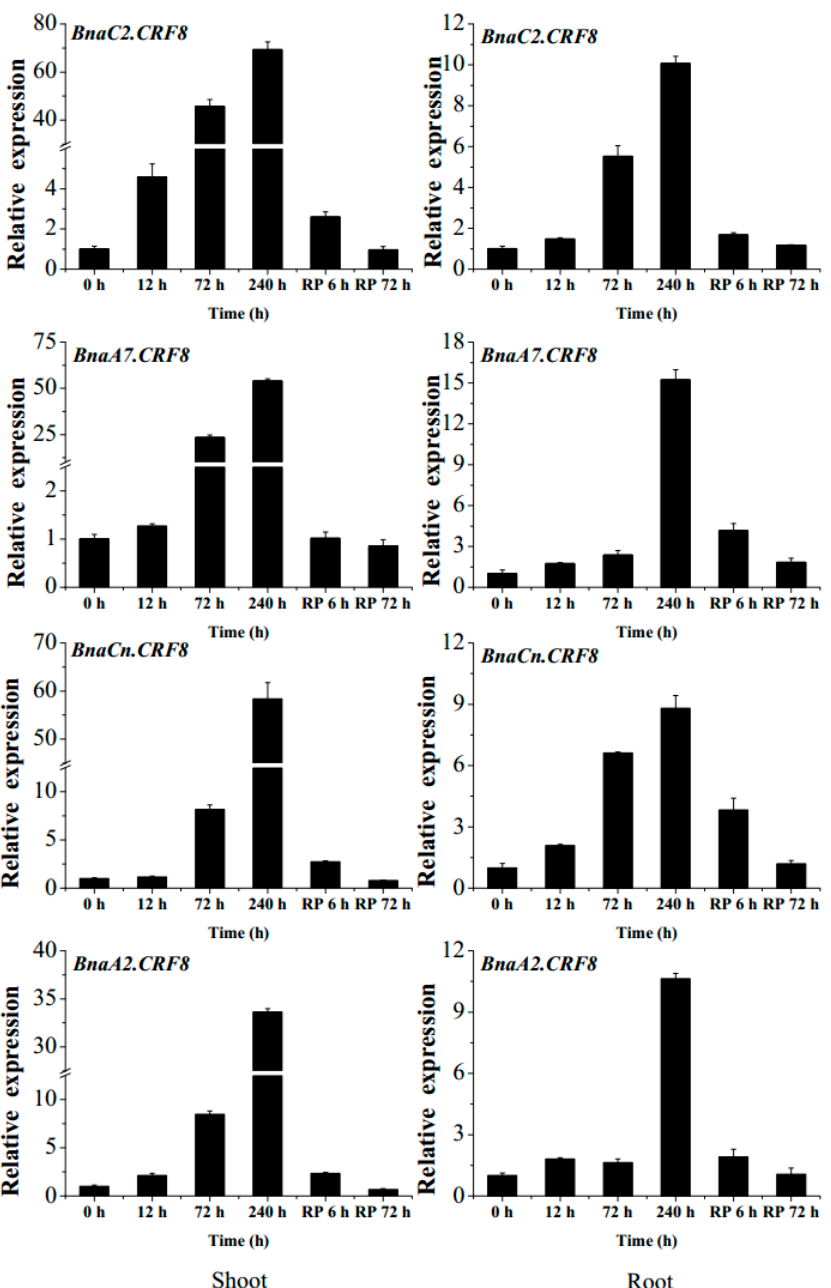
Figure 4. The expression changes of the 4 BnaCRF8 genes in response to phosphate (Pi) deficiency and recovery in Brassica napus . Fifteen-day-old plants were treated with Pi starvation (0 µ M Pi) for 10 days before Pi recovery (RP). Then, the shoots and roots of the plants were sampled separately, and qRT-PCR was performed at 6 time points (0, 12, 72, and 240 h after Pi starvation, and 6 and 72 h after RP). Values represent mean ± standard deviation (SD) of 3 biological replicates with 4 plants each.